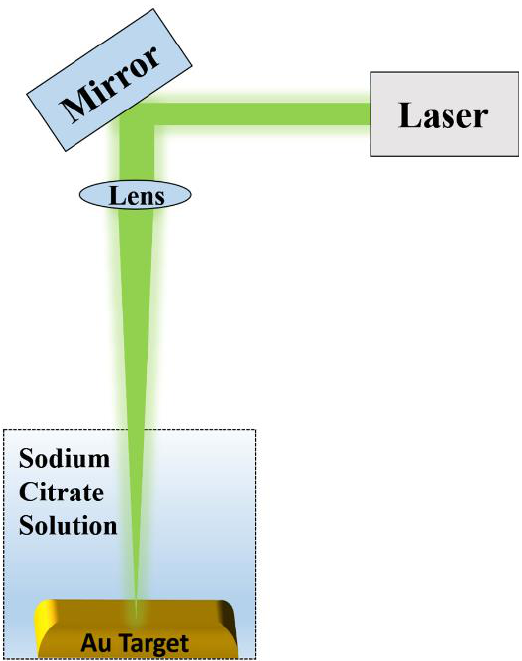
Figure 1. Schematic of the pulsed laser ablation process used for the synthesis of colloidal nanoparticles (NPs).